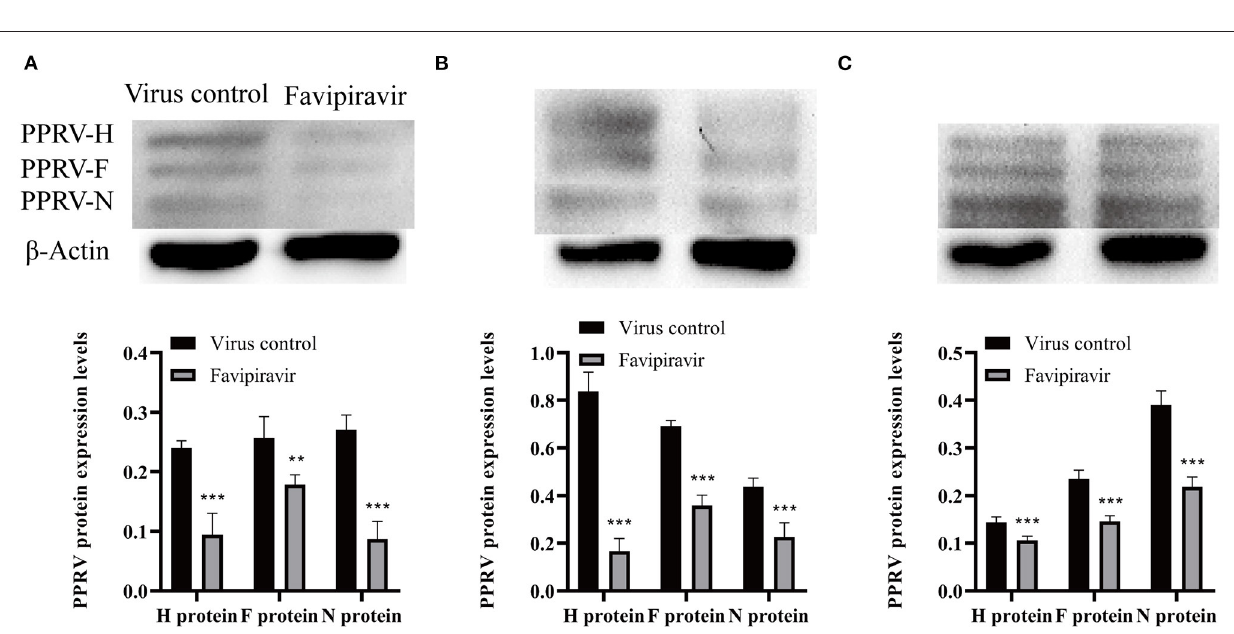
FIGURE 4 | Vero cells were infected with peste des petits ruminants virus (PPRV) at 100 TCID 50 /ml at 4 ◦ C for 1h, washed with cold phosphate-buffered saline (PBS) to remove unattached viruses, and then treated with favipiravir at 50 µ g/ml in maintenance medium supplemented with 2% fetal calf serum (FCS) for 1h at 37 ◦ C. The cells were then washed again with PBS to remove any extracellular viruses, and maintenance medium was added. The plates were incubated at 37 ◦ C, and the expression of the viral structural proteins H, F, and N was analyzed by Western blotting at (A) 36, (B) 48, and (C) 60h post-invasion (** p < 0.01, *** p < 0.001 vs. the virus-only